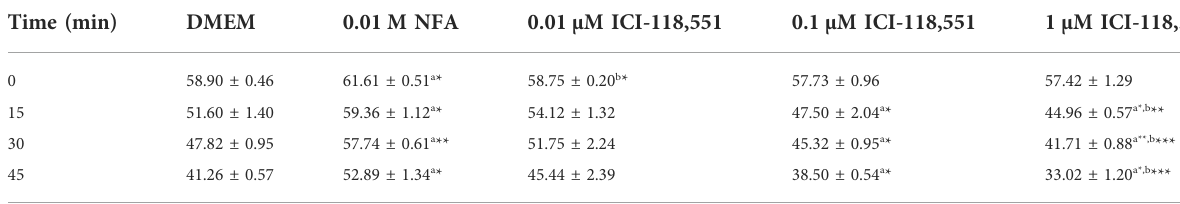
TABLE 1 Percent motility of sperm on exposure to different concentrations of ICI-118,551. Time (min)